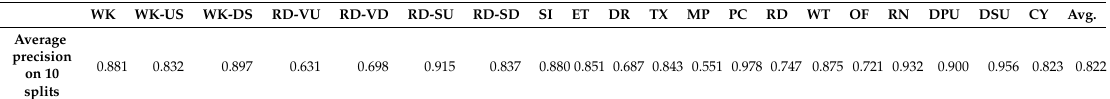
Table 15. Average F 1 accuracy of the 10 splits for each activity to be recognized.